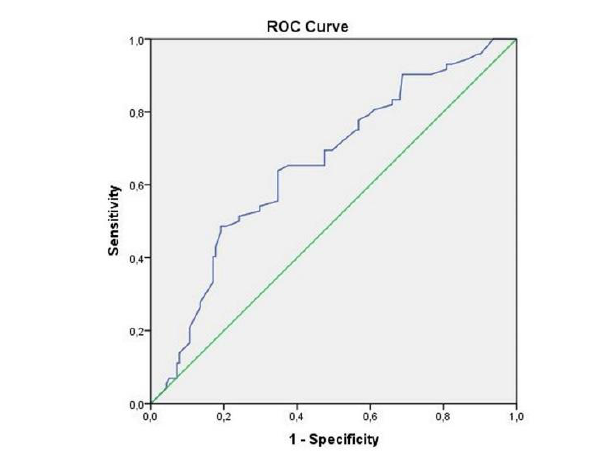
Figure 1: Receiver operator characteristic curve of the AIP to predict obstructive CAE in patients with NSTE-ACS (90% sensitivity and 68% specificity AUC: 0.658,